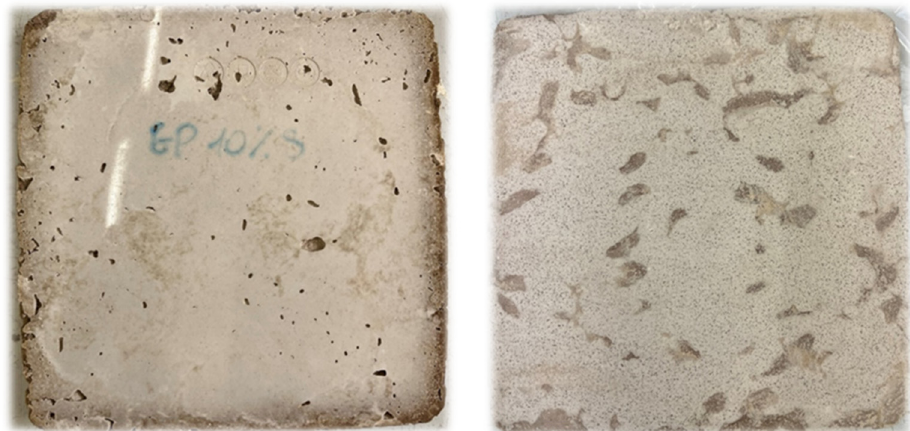
Figure 2. Images of the front and rear sides of the GP-9.1CW sample used for thermal conductivity test.